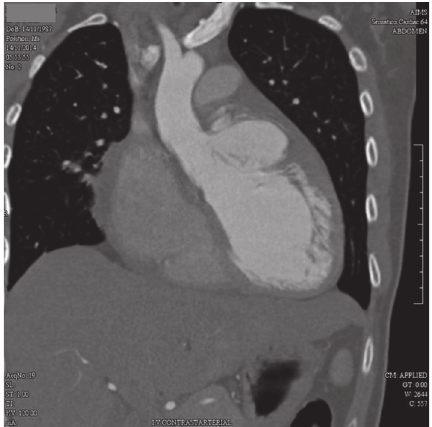
Figure 5: MDCT chest coronal section confirmed left and right sinus of Valsalva